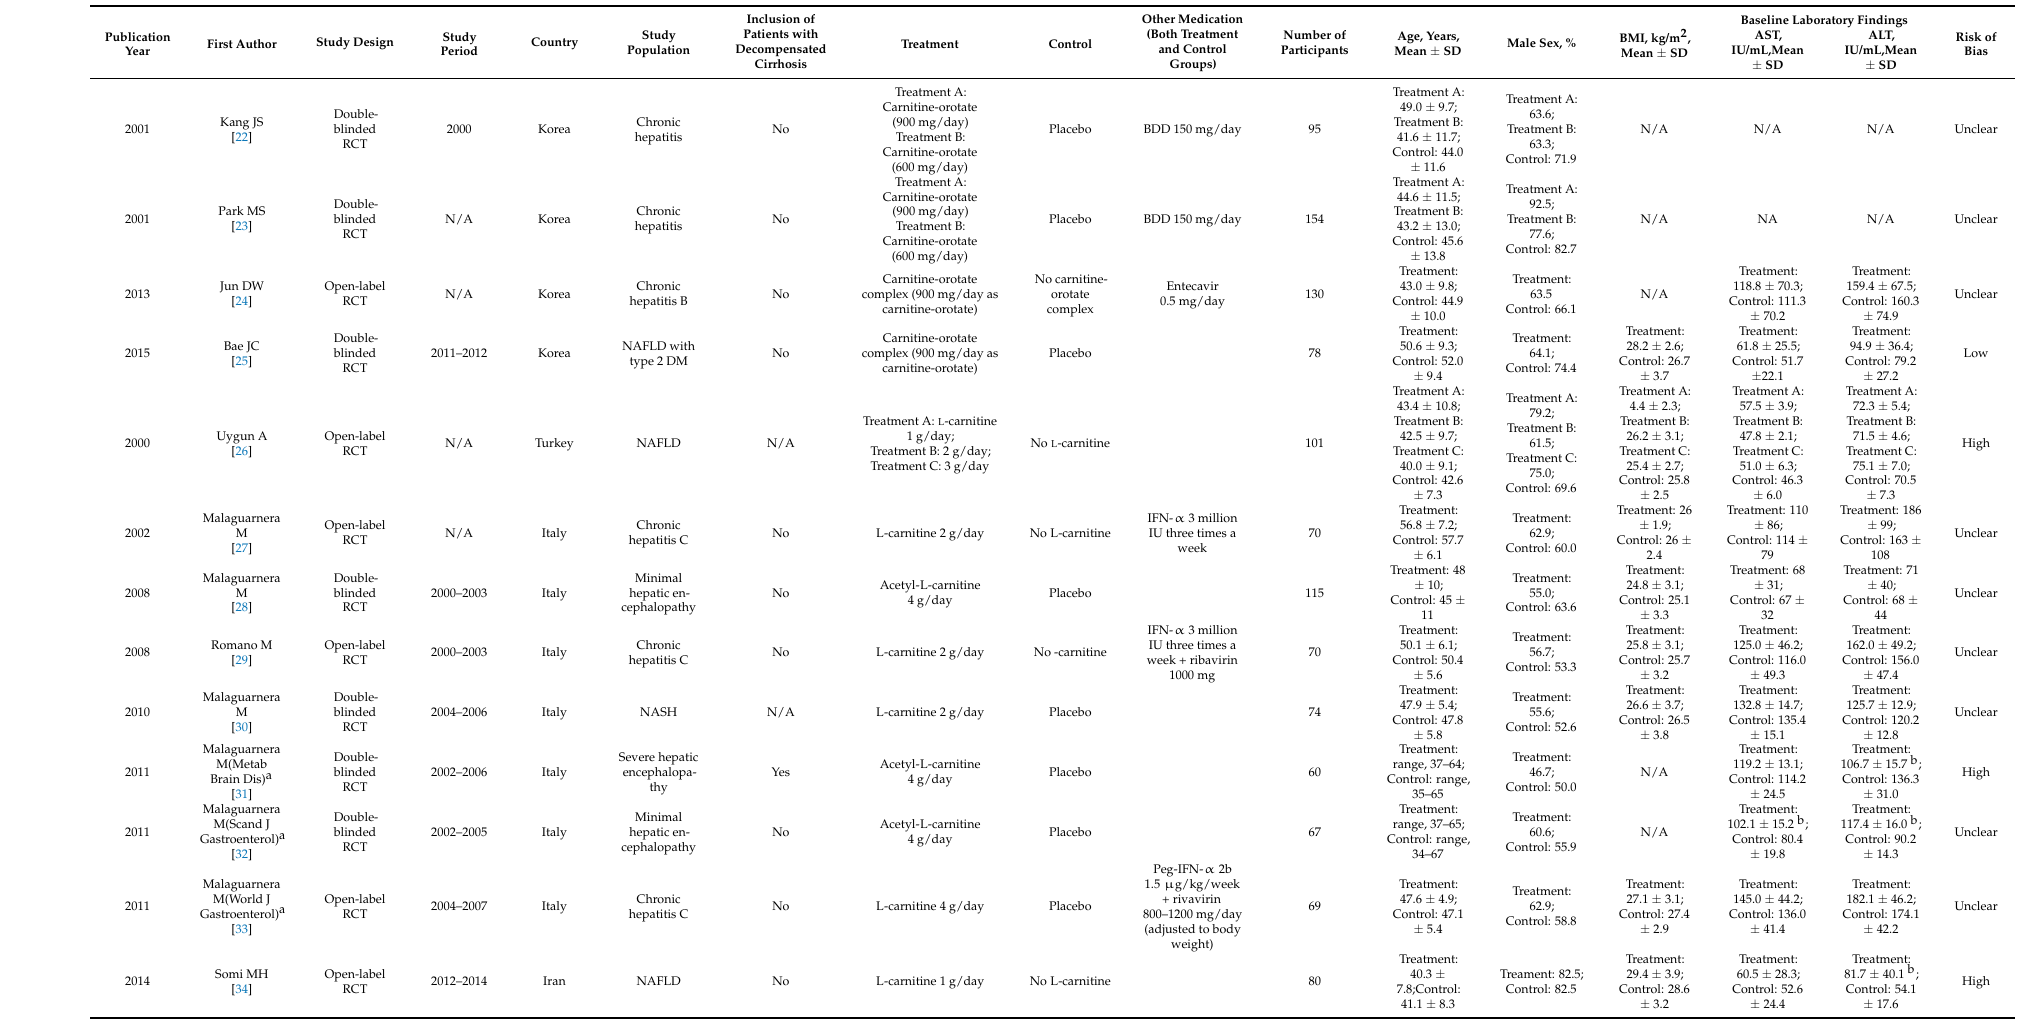
Table 2. Baseline characteristics of the included studies.